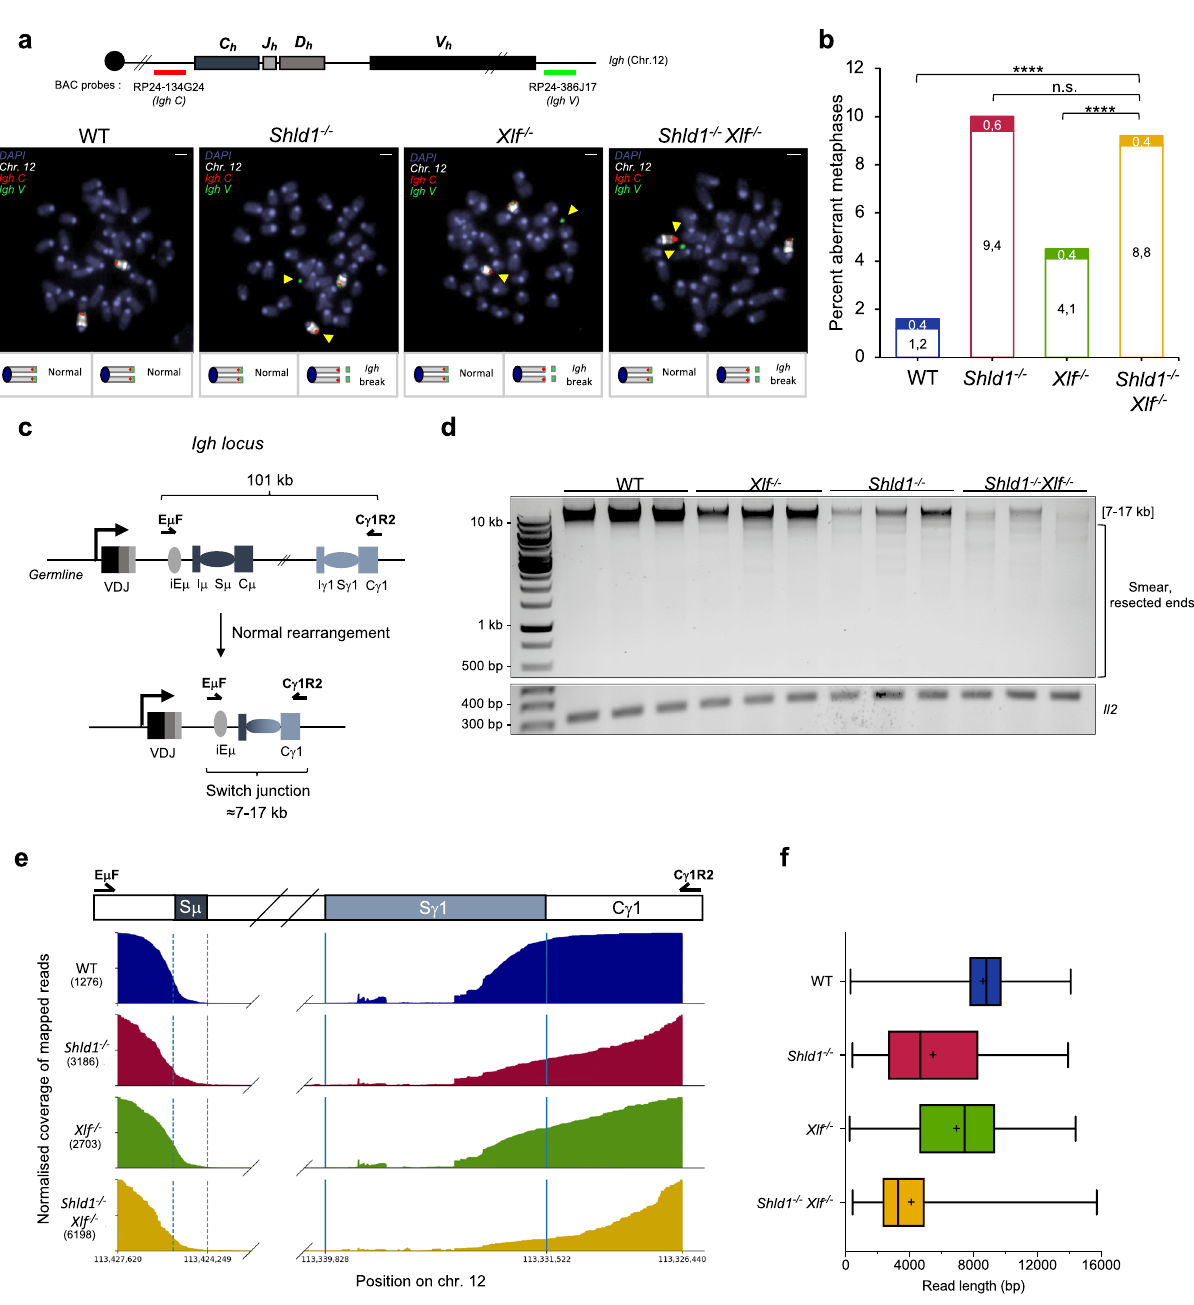
Fig. 4 SHLD1 promotes functional CSR in XLF-pro fi cient and XLF-de fi cient cells by limiting DNA end resection. a Representative images of Igh breaks in aberrant metaphases, as quanti fi ed in b. Scale bars, 3 μ m. b Quanti fi cation of Igh breaks (clear bar) and translocations ( fi lled bar) in metaphases of WT, Shld1 − / − , Xlf − / − , and Shld1 − / − Xlf − / − cells. Bars represent means. n = 1005 (WT), n = 1075 ( Shld1 − / − ) , n = 1201 ( Xlf − / − ), n = 1000 ( Shld1 − / − Xlf − / − ), two-sided Fisher ’ s exact test from four independent experiments (**** p <0.0001). See also Supplementary Table 4. c Schematic representation of the murine Igh locus. Arrows indicate primers used for the long-range PCR. d Long-range PCR analysis of S μ to S γ 1 rearrangements in WT, Xlf − / − , Shld1 − / − , and Shld1 − / − Xlf − / − stimulated B cells. Il2 gene PCR was used as a loading control. e Normalized coverage of the mapped PacBio reads in WT, Shld1 − / − , Xlf − / − , and Shld1 − / − Xlf − / − stimulated B cells. Vertical dashed lines indicate the S μ switch region and vertical lines indicate the S γ 1 region. f Distribution of read length (in bp) in WT, Shld1 − / − , Xlf − / − , and Shld1 − / − Xlf − / − cells. n = 3 independent samples. For all boxplots: minima is minimum value, maxima is maximum value, center is median and quartiles shown by box and whiskers, and cross is mean. n.s. non-signi fi cant ( p ≥ 0.05), **** p <0.0001. Source data are provided as a Source Data fi − / − , and Shld1 − / − Xlf − / − genotype. Results from these experi- to a fi xed “ bait ” DSB with nucleotide resolution to simultaneously quantify end resection, microhomology (MH) usage and orien- ments were highly reproducible (Fig. 5b, c and Supplementary tation of AID-generated DNA end-joining between the 5 ′ region Fig. 7). of S μ (the bait) and the downstream core S γ 1 region (the Consistent with class switching levels in these cells, XLF- prey) 13,14,48 (Fig. 5a). For this study, we analyzed >5,000 junc- de fi cient B cells, SHLD1-de fi cient B cells, and SHLD1/XLF- tions from three independent mice of each wildtype, Shld1 − / − , Xlf de fi cient B cells had reduced S γ 1 junctions compared to wild-type